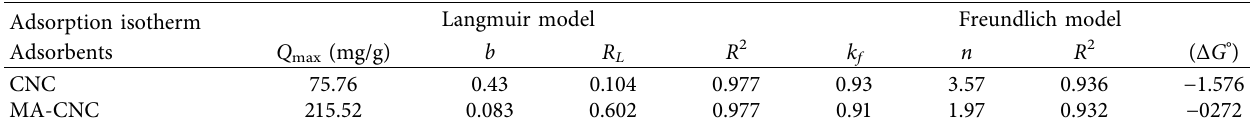
Table 2: Langmuir and Freundlich isotherm constants for Cd(II) ion adsorption by CNC and MA-CNC sorbent at 25 ° C.